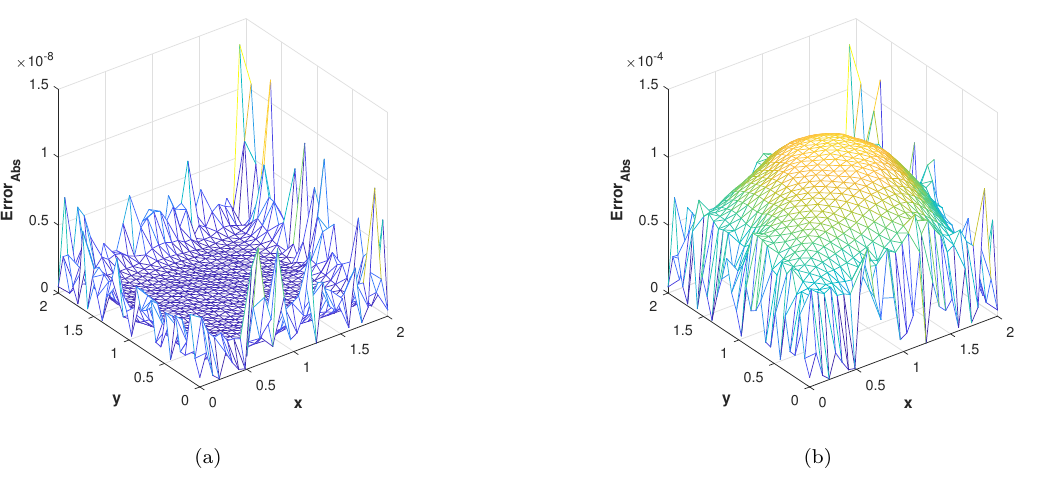
Figure 19: (a) Contour plot of Ab Error at time level T = 1. (b) Contour plot of Rms Error with 3375 , σ n = 80 , N S = 20 at time level T = 1 .